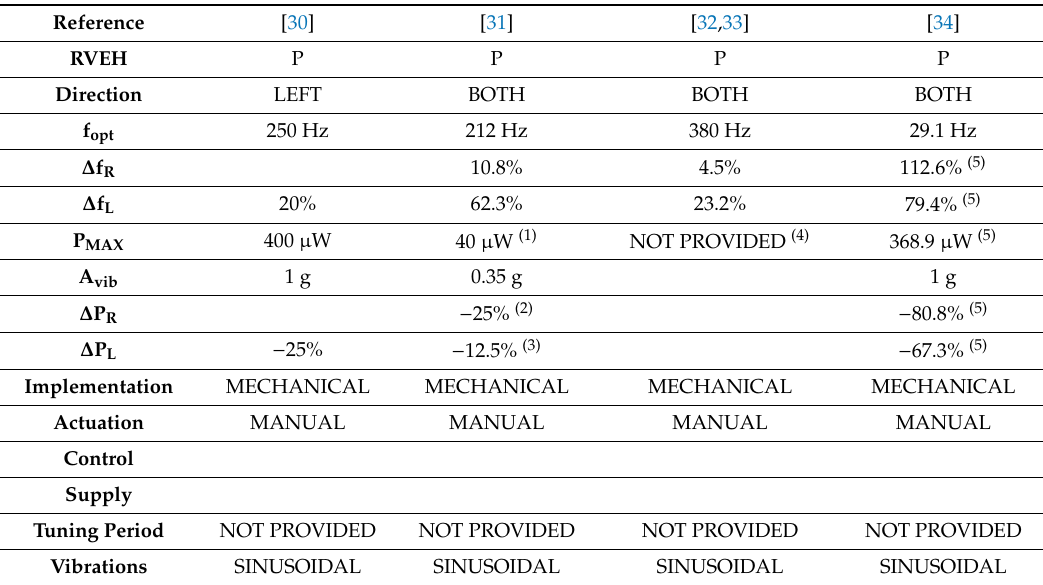
Table 4. Axial preloads based MTTs classification